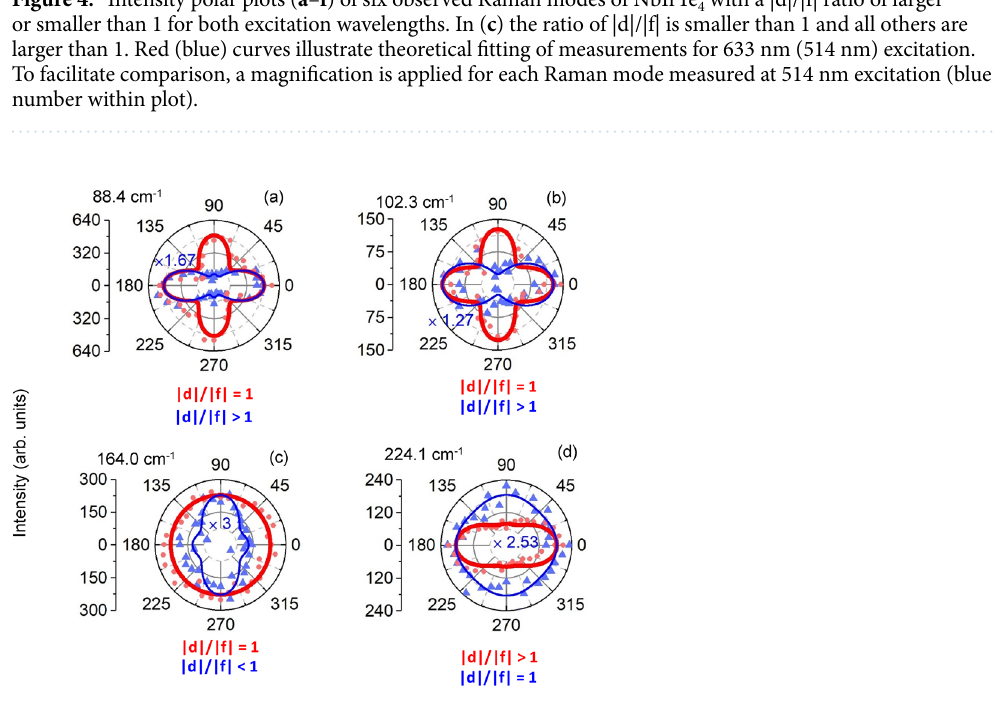
Figure 5. Intensity polar plot of four observed Raman modes of NbIrTe 4 with |d|/|f| ratio equals 1 for one of the excitation energies. Plots ( a – c ) show modes where just for measurement of the 633 nm excitation the ration of |d|/|f| equals 1, and plot ( d ) shows the mode where just for measurement of the 514 nm excitation the ration of |d|/|f| equals 1. Red (blue) curves illustrate theoretical fitting of measurement by 633 nm (514 nm) laser beam. The factor of magnification for each Raman mode measured by 514 nm laser is declared by blue number at each